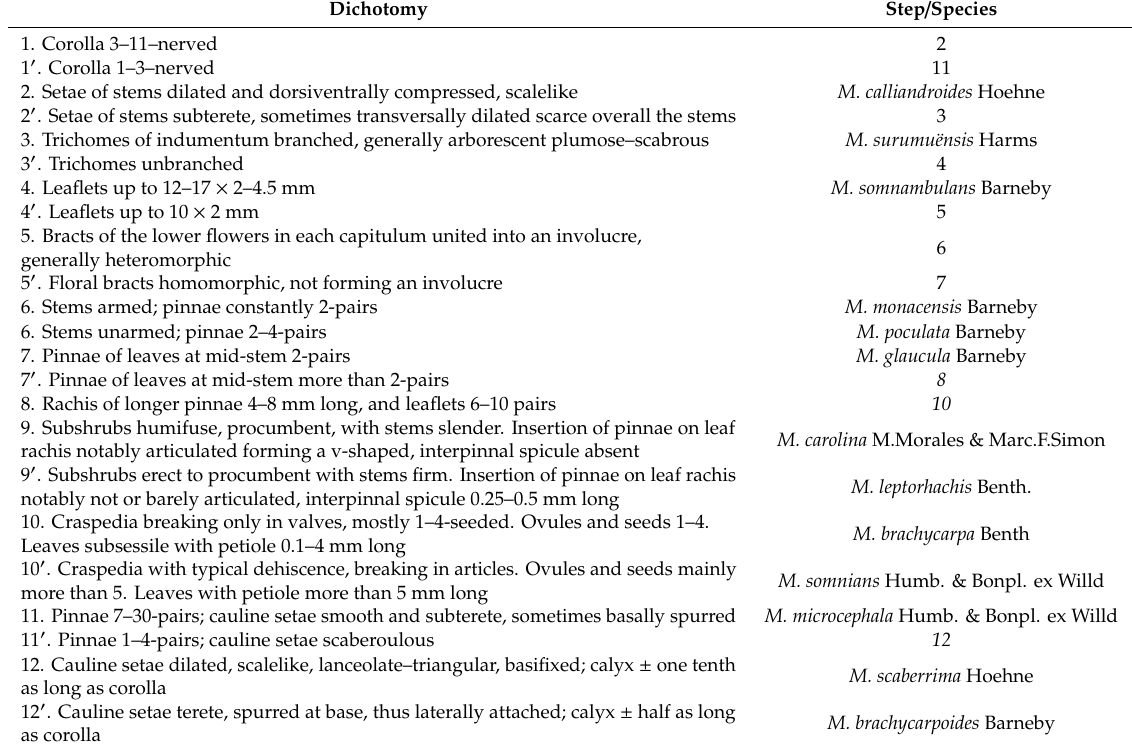
Table 1. Key to Identify Mimosa carolina and Similar Species from Mimosa sect. Habbasia ser. Bipinnatae (Steps 2, 11 and 12 are adapted from Barneby